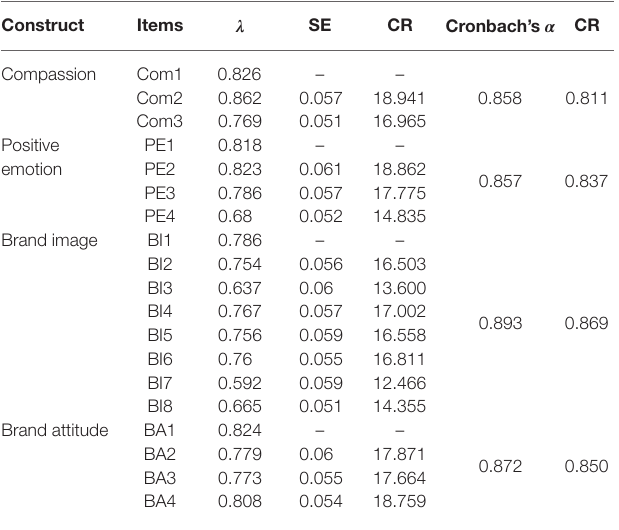
TABLE 1 | Confirmatory factor analysis